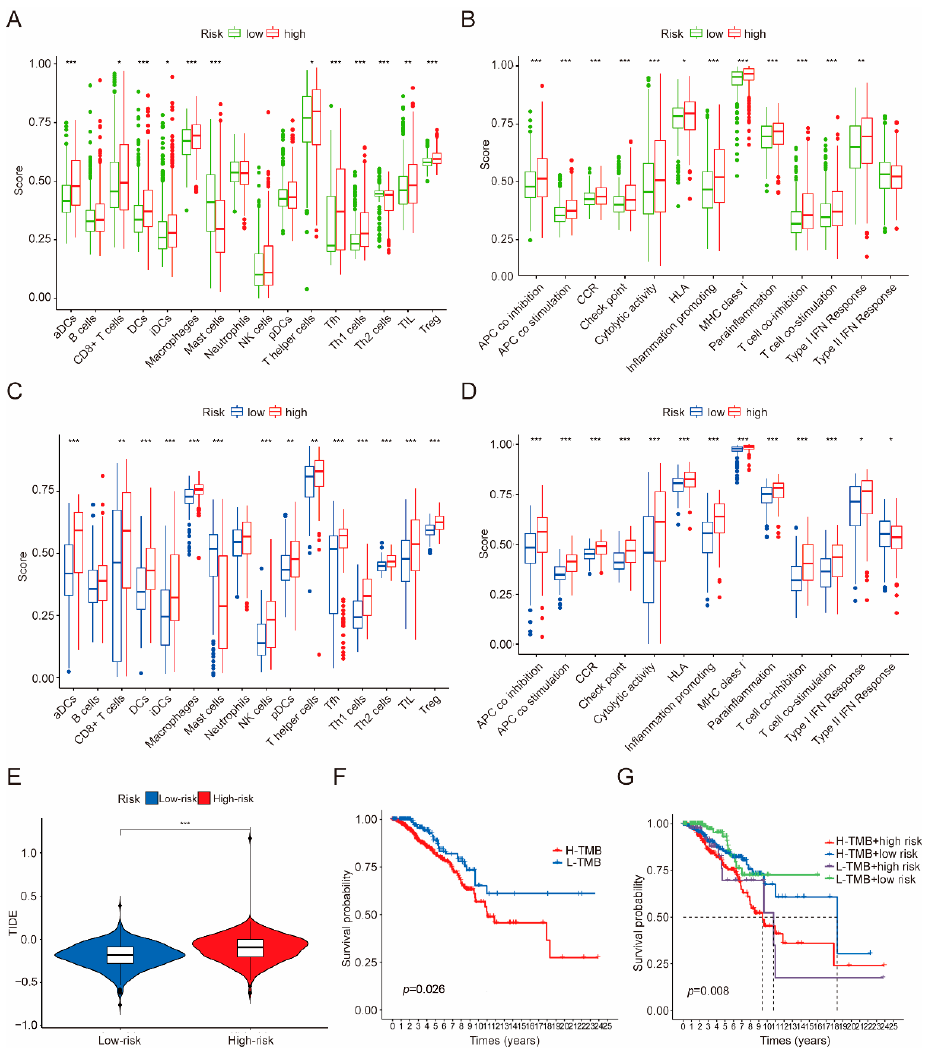
Figure 8. Comparison analysis of immune cells and immune pathways based on ssGSEA scores. ( A , B ) Comparison analysis of the enrichment scores of immune cells and immune-related pathways in training dataset (TCGA). ( C , D ) Comparison of the immune signaling pathways between low- ** p < 0.01; *** p < 0.001. ( E ) TIME comparison among risk groups in training set. ( F )